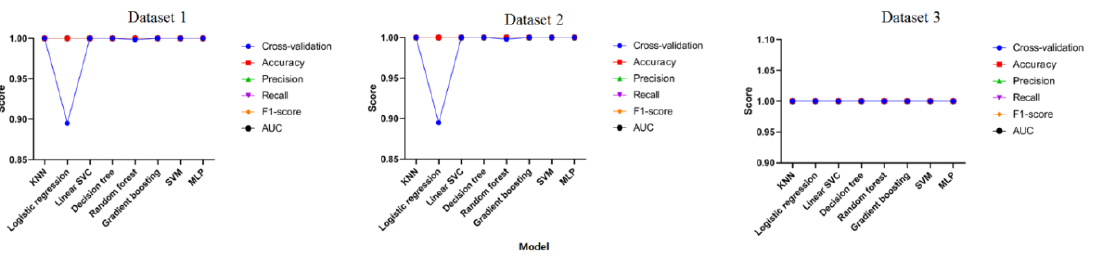
Figure 7. Comparison of performance evaluation according to each set and cross-validation by features.